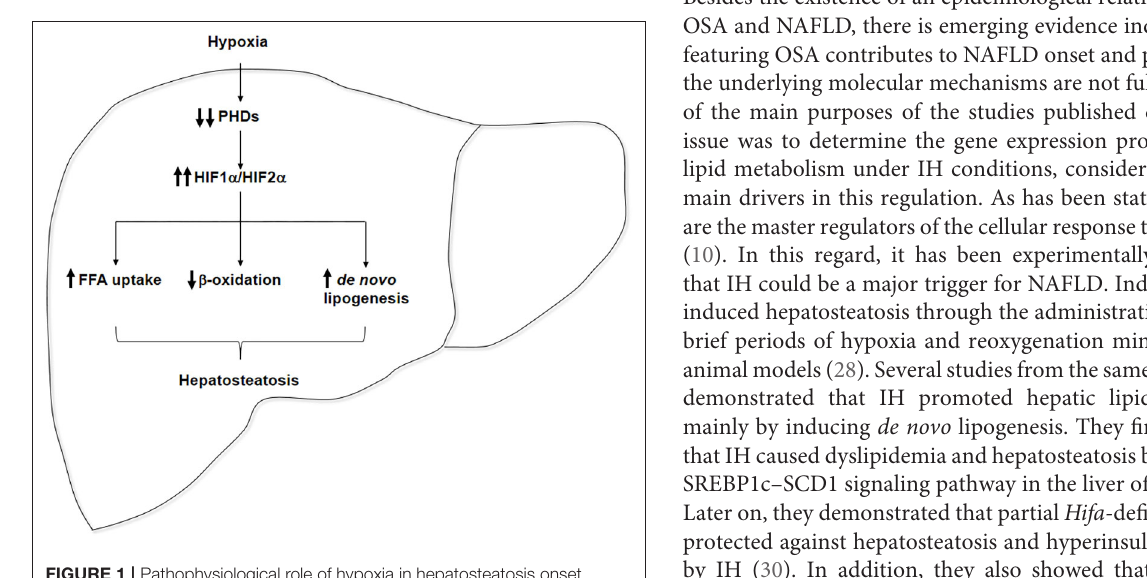
FIGURE 1 | Pathophysiological role of hypoxia in hepatosteatosis onset. Hypoxia inactivates prolyl hydroxylase domains (PHDs), enhancing hepatic HIF1 α and HIF2 α expressions, which could contribute to hepatosteatosis onset by the upregulation of free fatty acid (FFA) uptake, the repression of FFA β -oxidation, and the stimulation of de novo